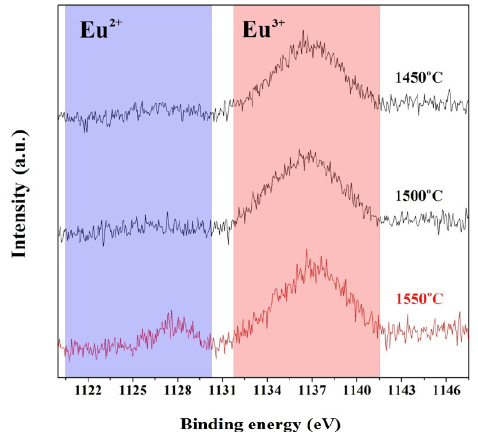
Fig. 5 High-resolution XPS spectra of the Eu 3d peaks of Ba 0.79 Al 10.9 O 17.14 :0.04Eu.